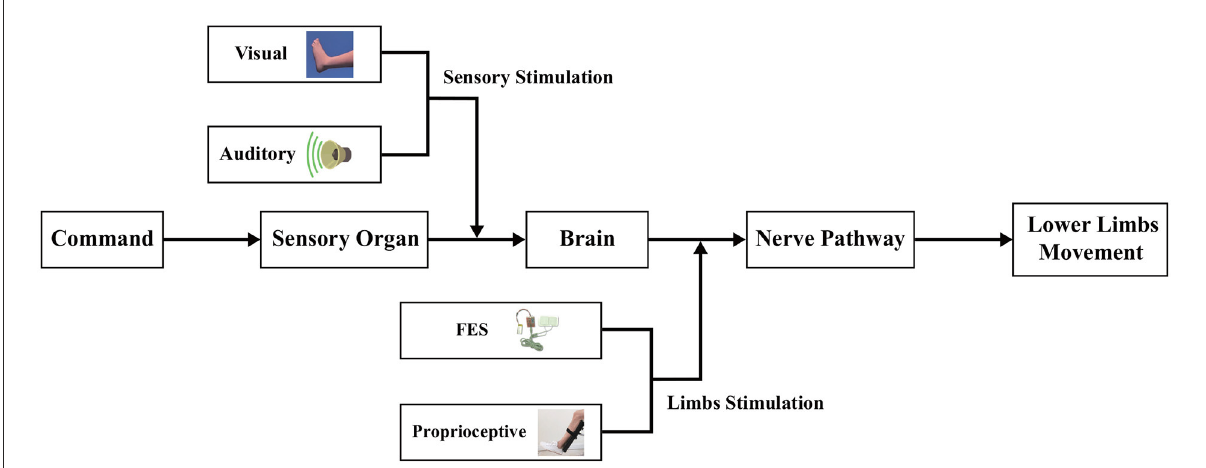
FIGURE1 The framework of the multi-modal dual-level stimulation paradigm. The visual and auditory stimulations act on the sensory organ while the FES and tactile stimulations act on the lower